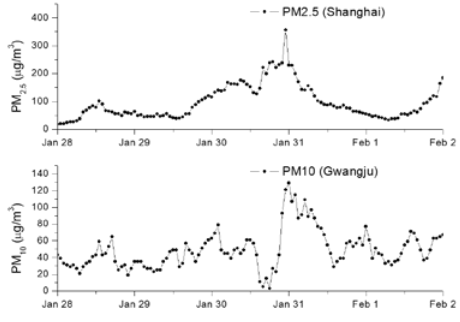
Figure. 3. Hourly variation of PM 2.5 concentration in Shanghai, China and PM 10 concentration in Gwangju, Korea during Lunar New Year period in